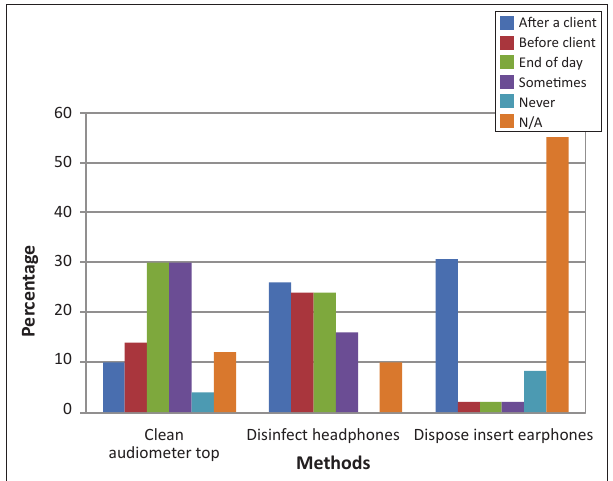
FIGURE 2: Methods of minimising infectious disease in audiology